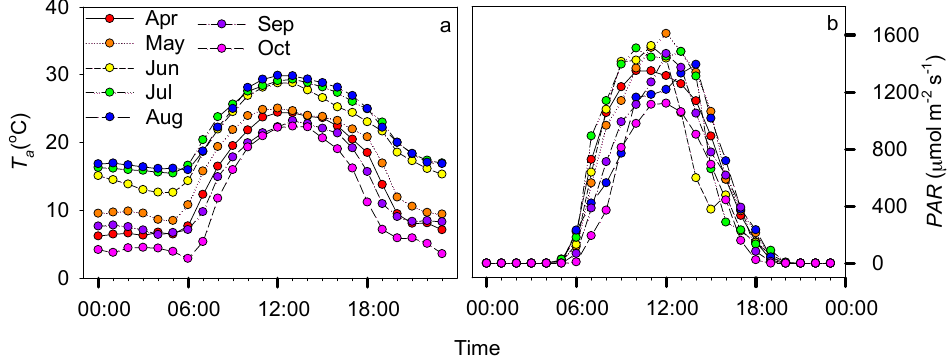
Figure 1. Monthly mean diurnal cycle of air temperature ( T a , ( a )) and photosynthetically active radiation ( PAR , ( b )) during the growing season (April–October) of 2012.